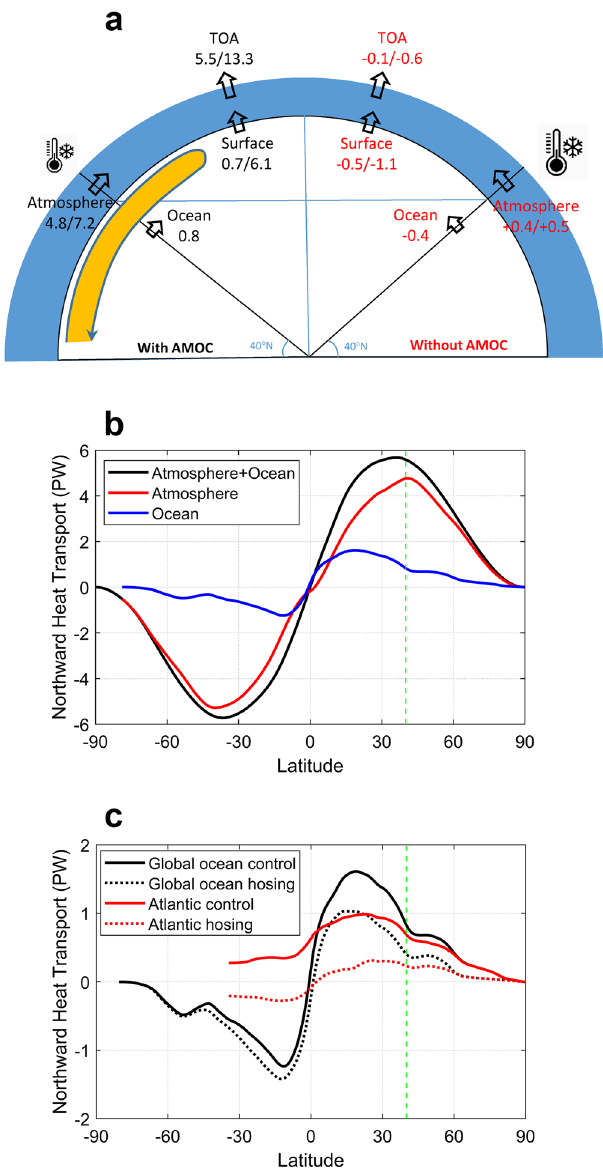
Fig. 1 Energy balance of the northern atmosphere in the climates with and without an active AMOC. a Schematic shows the energy balance for the entire atmosphere north of 40°N. The left half with black numbers (annual/DJF) shows heat fl uxes (PW) at the top, bottom and southern boundaries in the long-term control run of CM4C192. The right half with red numbers shows the heat fl ux anomalies during years 21 – 100 of the hosing experiment relative to the control. The positive and negative values indicate enhanced and reduced heat fl uxes, respectively. Only the annual mean value is shown for the oceanic transport. The blue and yellow shadings denote the atmosphere and AMOC, respectively. b Annual northward heat transport by the global atmosphere and global ocean as a function of latitude in the control run. c Annual northward heat transport of the global ocean and the Atlantic in the control and during years 21 – 100 of the hosing experiment. The green vertical dashed line marks